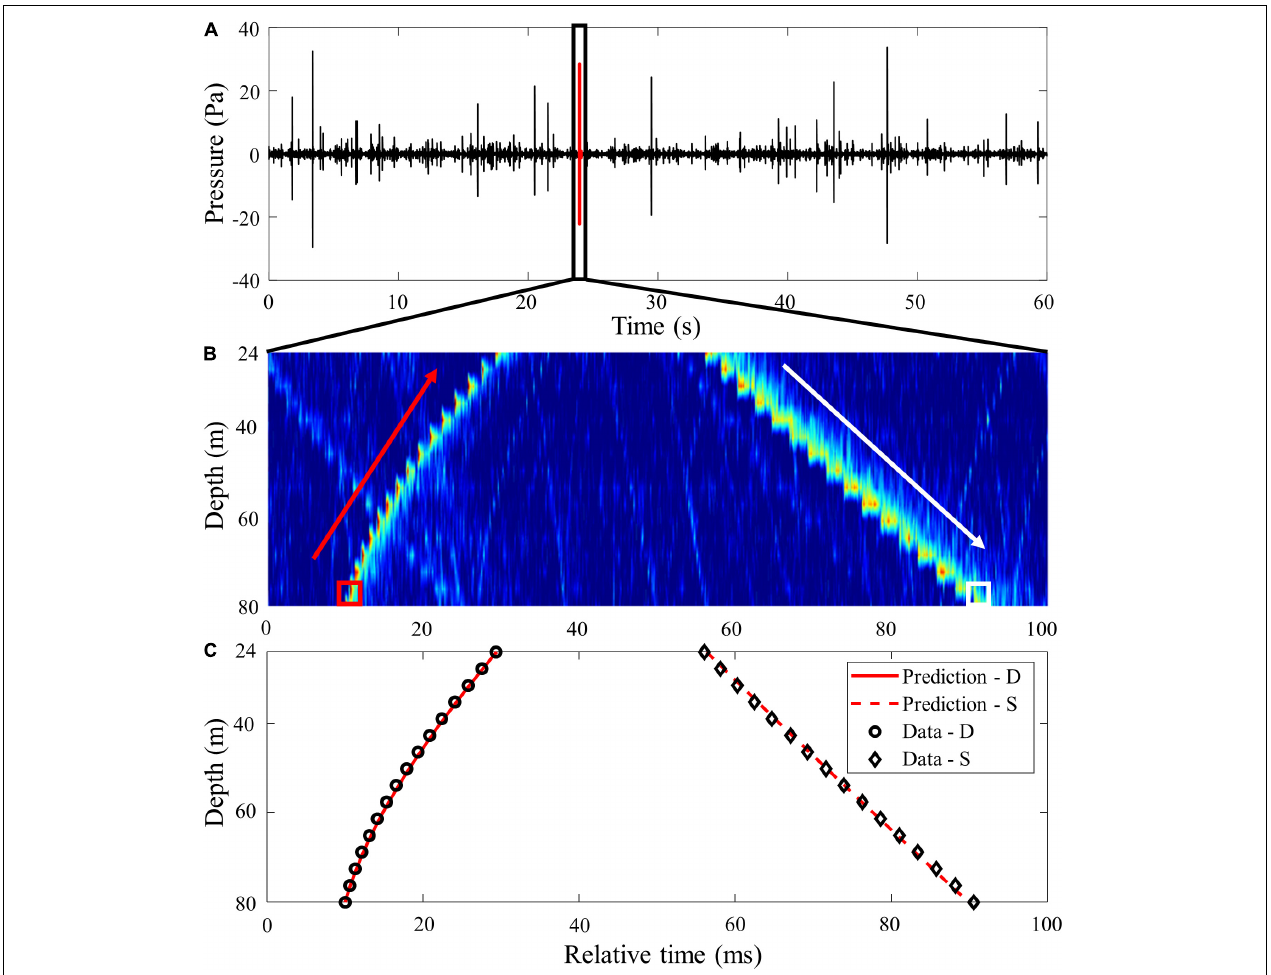
FIGURE 3 | (A) Example of ambient noise data received for 1 min at the bottommost hydrophone (81 m) of VLA1 on JD 141 at 12:00 UTC, exhibiting many impulsive snapping shrimp noise. (B) Arrival structure of a single snapping shrimp noise in array depth and time over a 100-ms long time window, zoomed in on the black box in panel (A) . The red arrow indicates that the snapping shrimp noise propagates spherically from the bottom to the sea surface, whereas the white arrow indicates a linear downward propagation of the sea surface-reflected snapping shrimp noise. (C) Model and data comparison for direct (D) and surface-reflected (S) arrival. The model assumes the source on the sea floor is at 75-m range from the